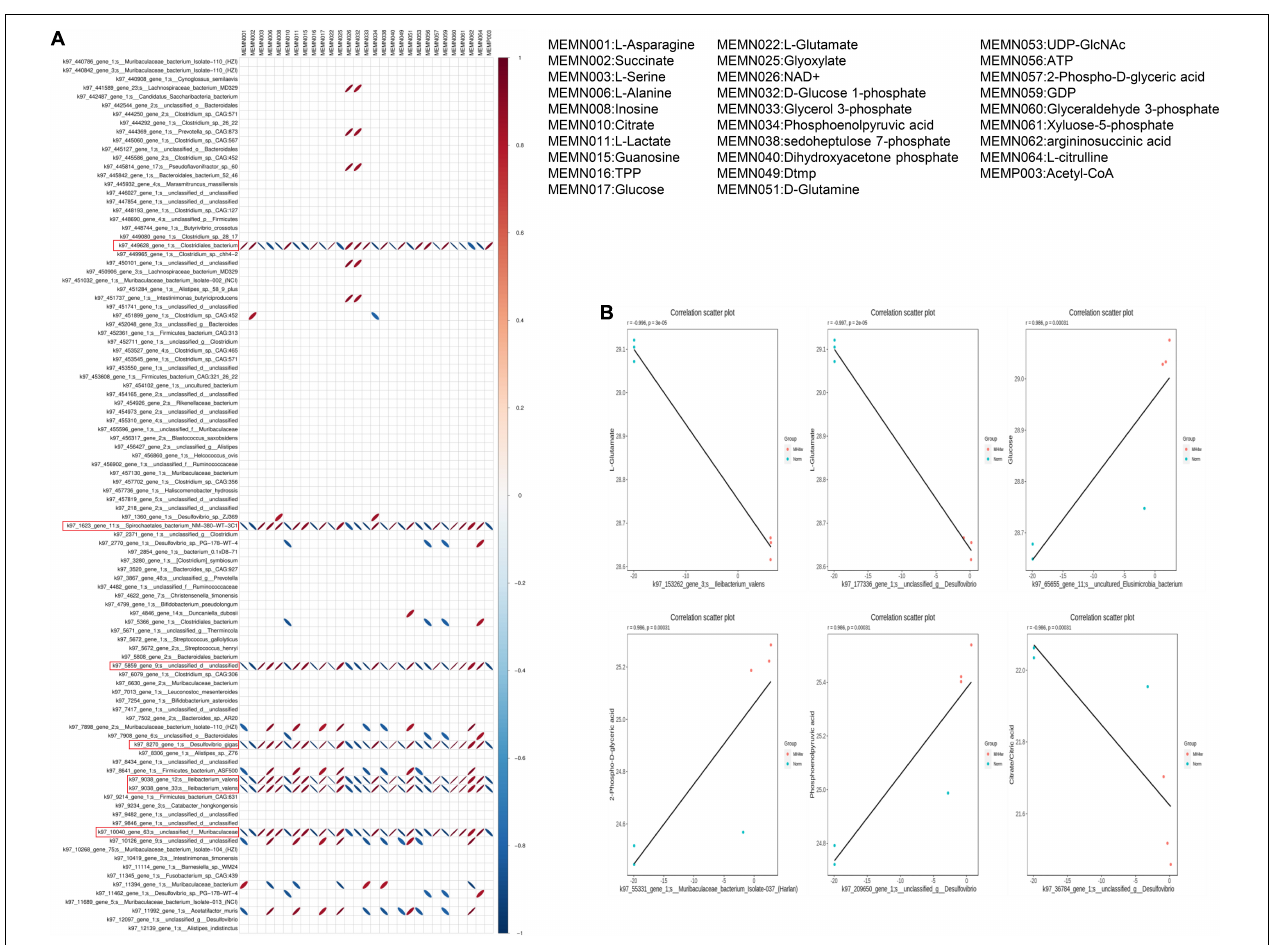
FIGURE 7 | Correlation between differential metabolites and microorganisms. (A) The correlation heatmap of metabolites and microorganisms; red ellipses indicate positive relationship, blue ellipses indicate negative relationship (narrow ellipse = stronger correlation). (B) Scatter plots of some gut microflora–related metabolites, including L-Glutamate, glucose, 2-Phospho-D-glyceric acid, phosphoenolpyruvic acid, and citrate/citric